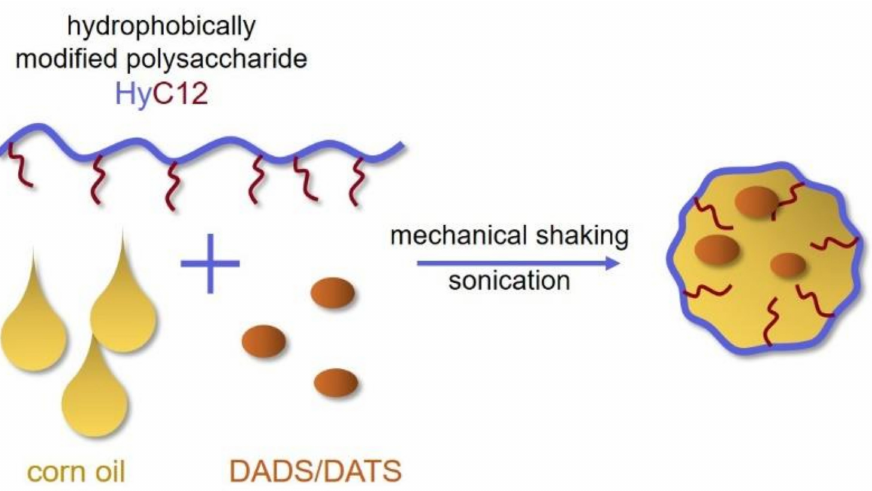
Figure 1. Scheme illustrating preparation of the nanocapsules with diallyl disulfide (DADS) or diallyl trisulfide (DATS) cargo